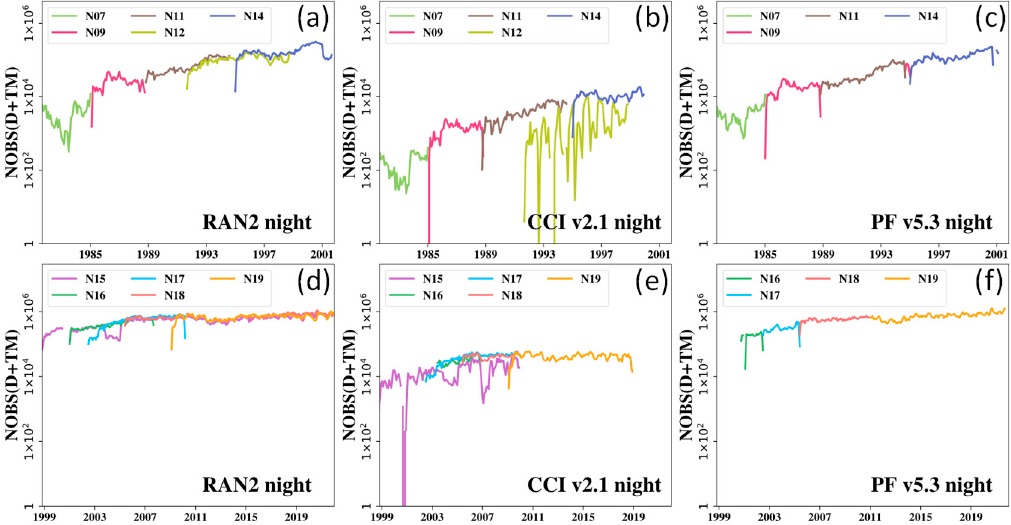
Figure 12. Monthly numbers of matchups with (D + TM) for ( a , d ) RAN2, ( b , e ) CCI and ( c , f ) PF L3C SSTs, for ( a – c ) AVHRR/2 and ( d – f ) AVHRR/3 radiometers. (Data are from the NOAA SQUAM system [21,22]).